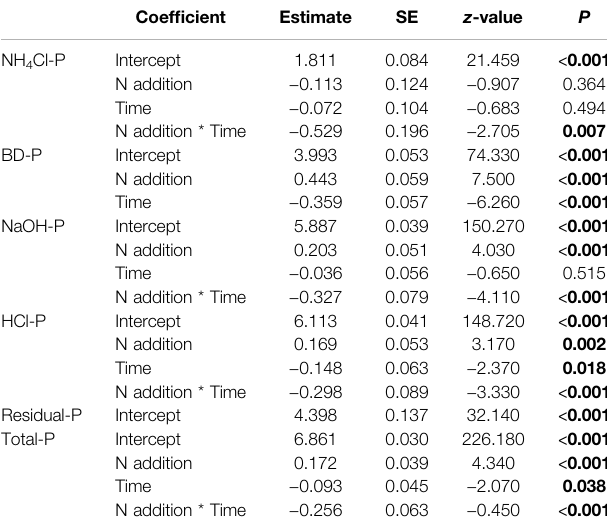
TABLE 2 | Best results of the generalized linear mixed model for sediment P fractions. Units are mg m − 2 . Coef fi cient